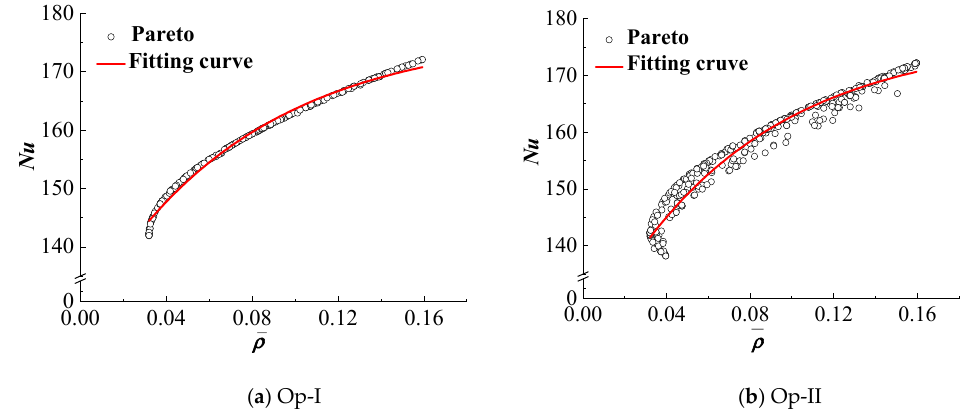
Figure 10. Pareto fronts and fitting curves of XLS of ( a ) Op-I and ( b ) Op-II. Table 7. Coefficients of the set of Pareto optimized solutions in fitting function.